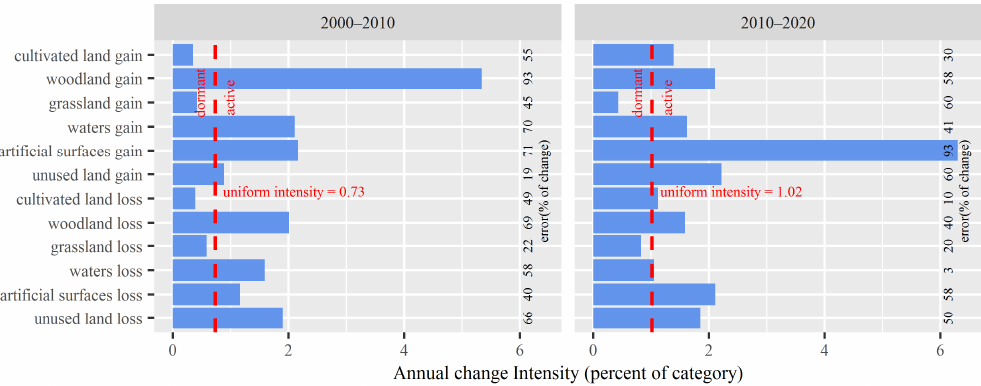
Figure 4. Category level gain and loss intensities through two time intervals for the upper reaches of the YRB. The red vertical dashed line is the uniform intensity line.